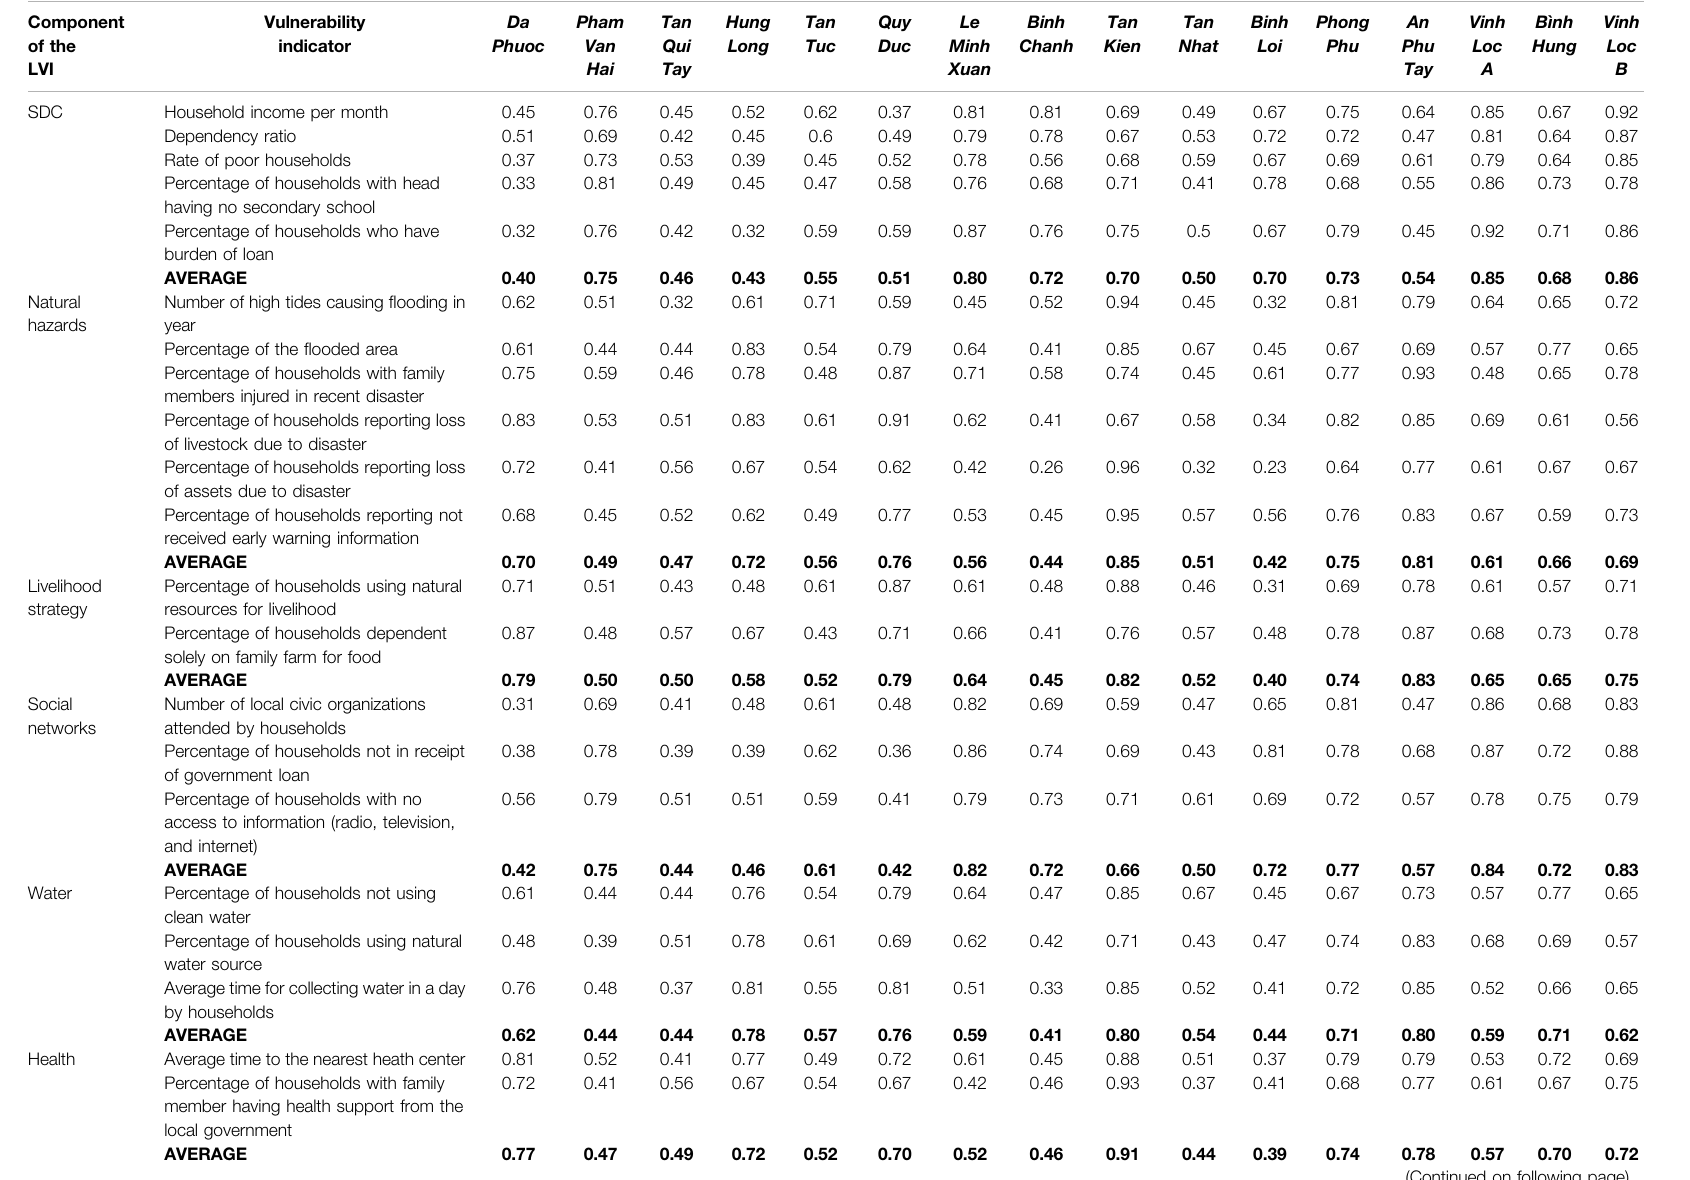
TABLE 2 | Livelihood vulnerability index (LVI) of components for the communes of the Binh Chanh district. Component of the LVI